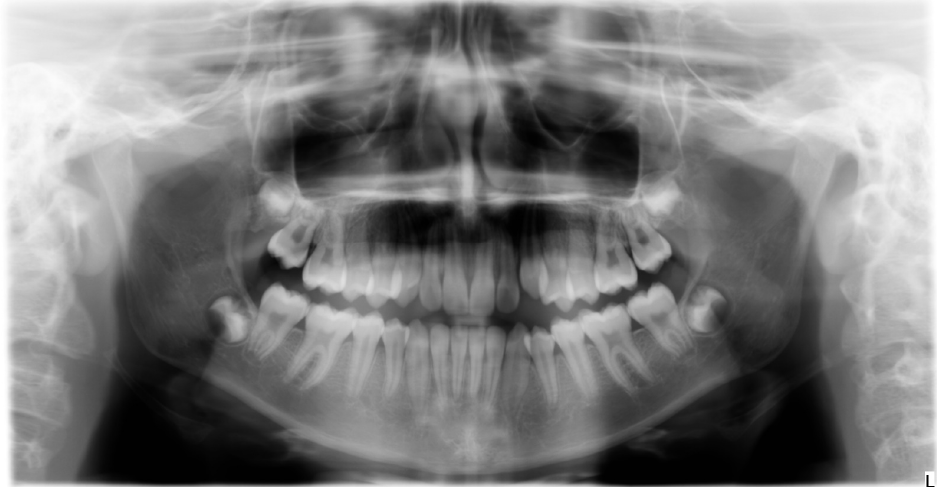
Figure 36. Radiographs of the patient at the screening. Orthopantomography X-ray after treatment and a 3-year follow-up period (12-year-old).